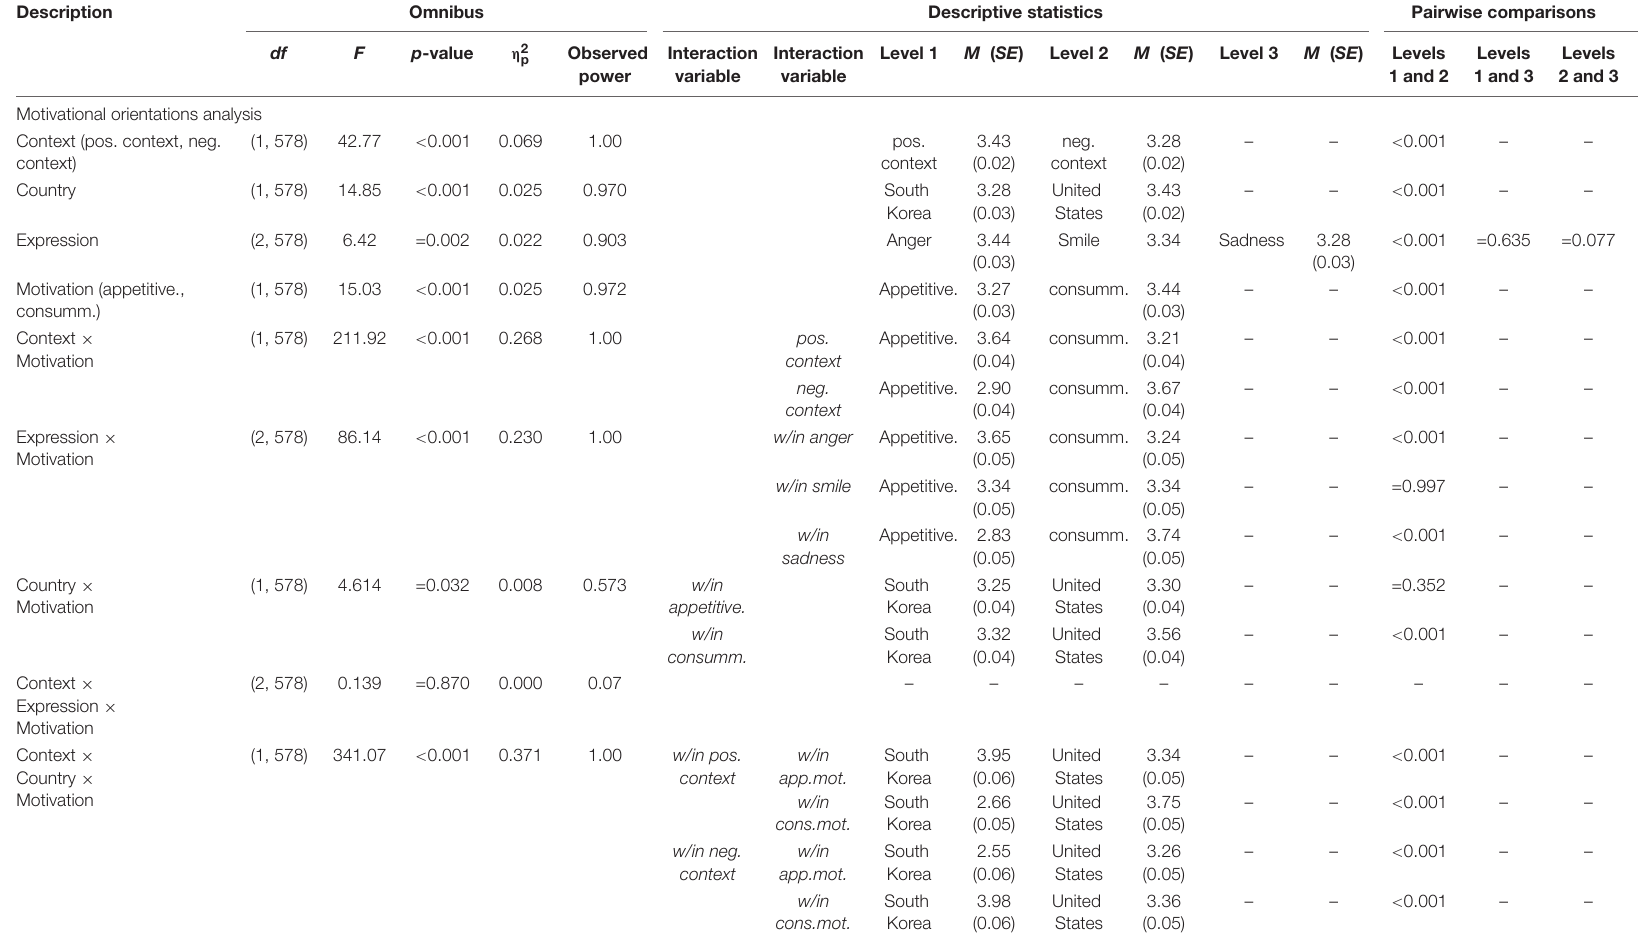
TABLE 4 | General linear repeated measures models testing inferred motivational orientations, and seen, known, used